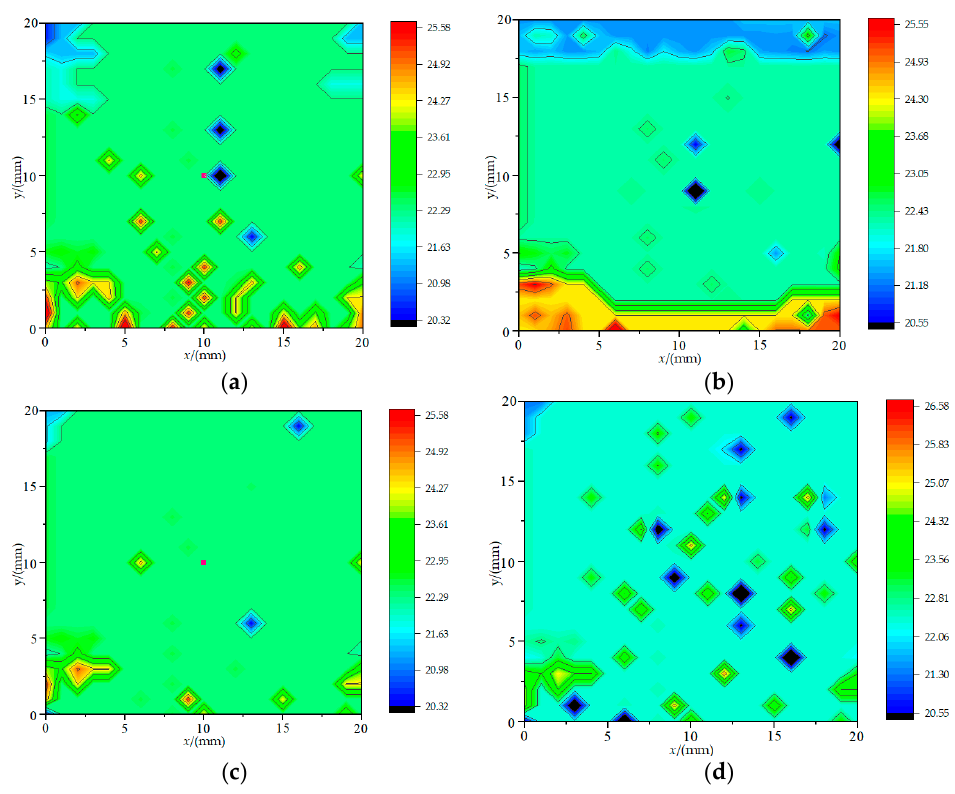
Figure 12. ( a ) Uniformity of coverage at F3M1 level; ( b ) Uniformity of coverage at F3M2 level; ( c ) Uniformity of coverage at F3M3 level; ( d ) Uniformity of coverage at F3M4 level.